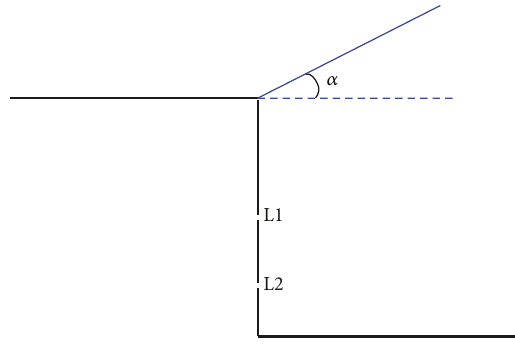
Figure 4: Modifications for passive and active flow control.